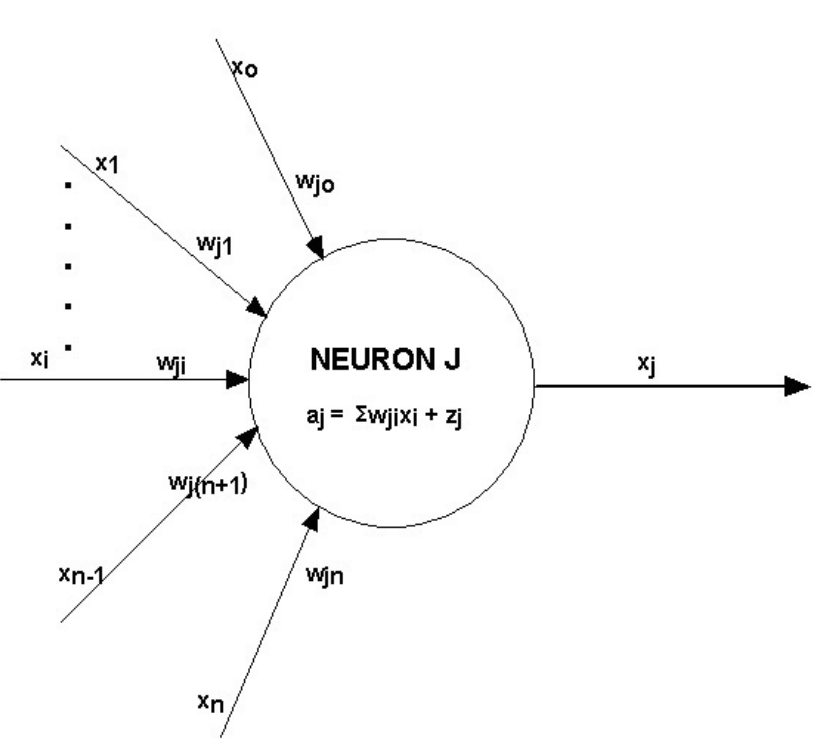
FIGURE 3. The basic processing element (a neuron) in a network receives several input connection values associated with a weight. The resulting output value is computed in accordance with the presented equations (see the